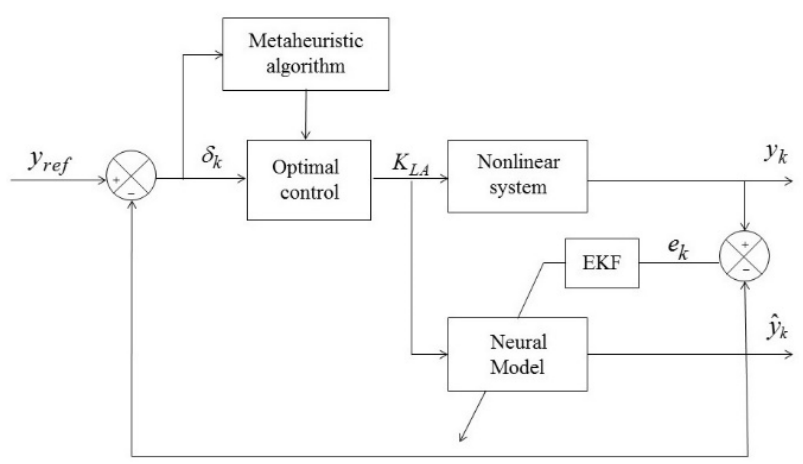
Figure 5. Optimal neural tracking control strategy for nonlinear systems.